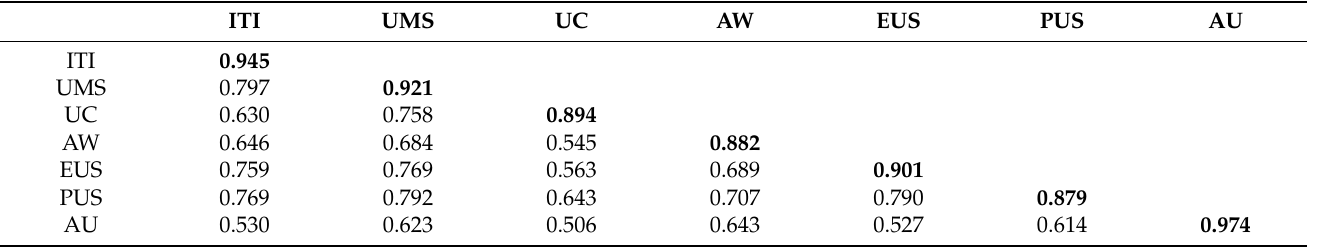
Table 3. Discriminant validity analysis.